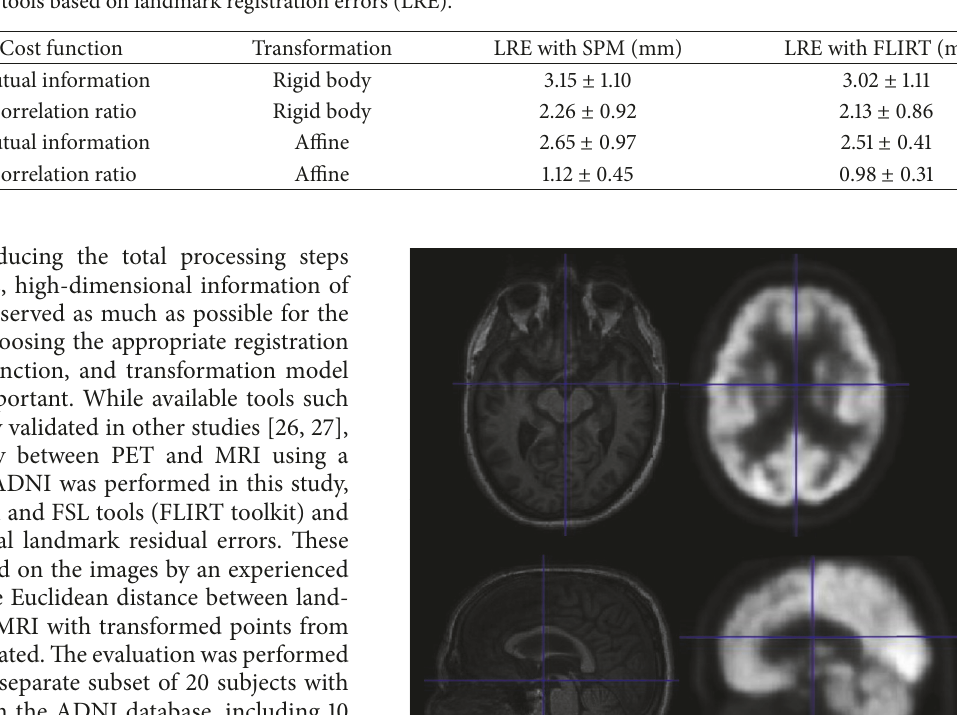
Table 2: Configuration of cost function and transformation model (rigid with 6 parameters versus affine with 12 parameters) of registration, comparing SPM and FLIRT tools based on landmark registration errors (LRE).